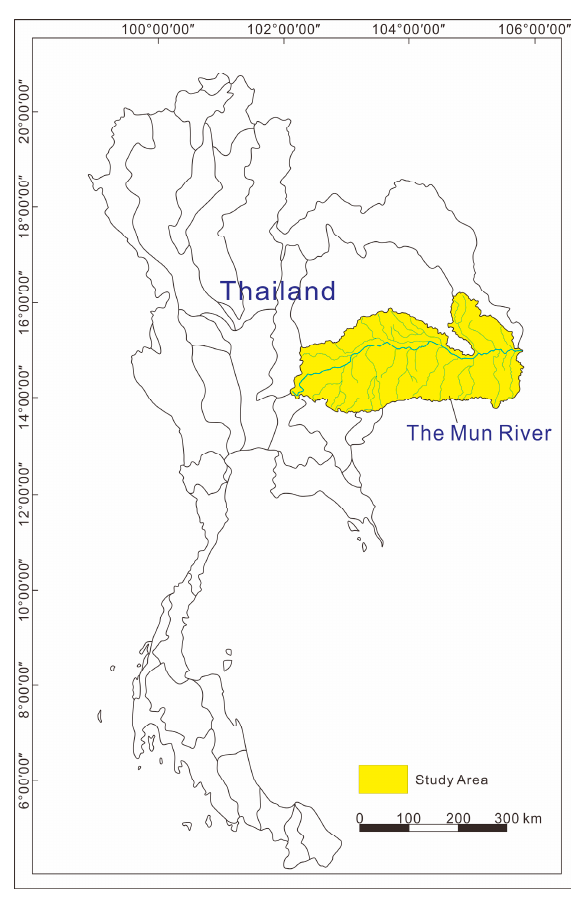
Figure 1. Location of the Mun River Basin.